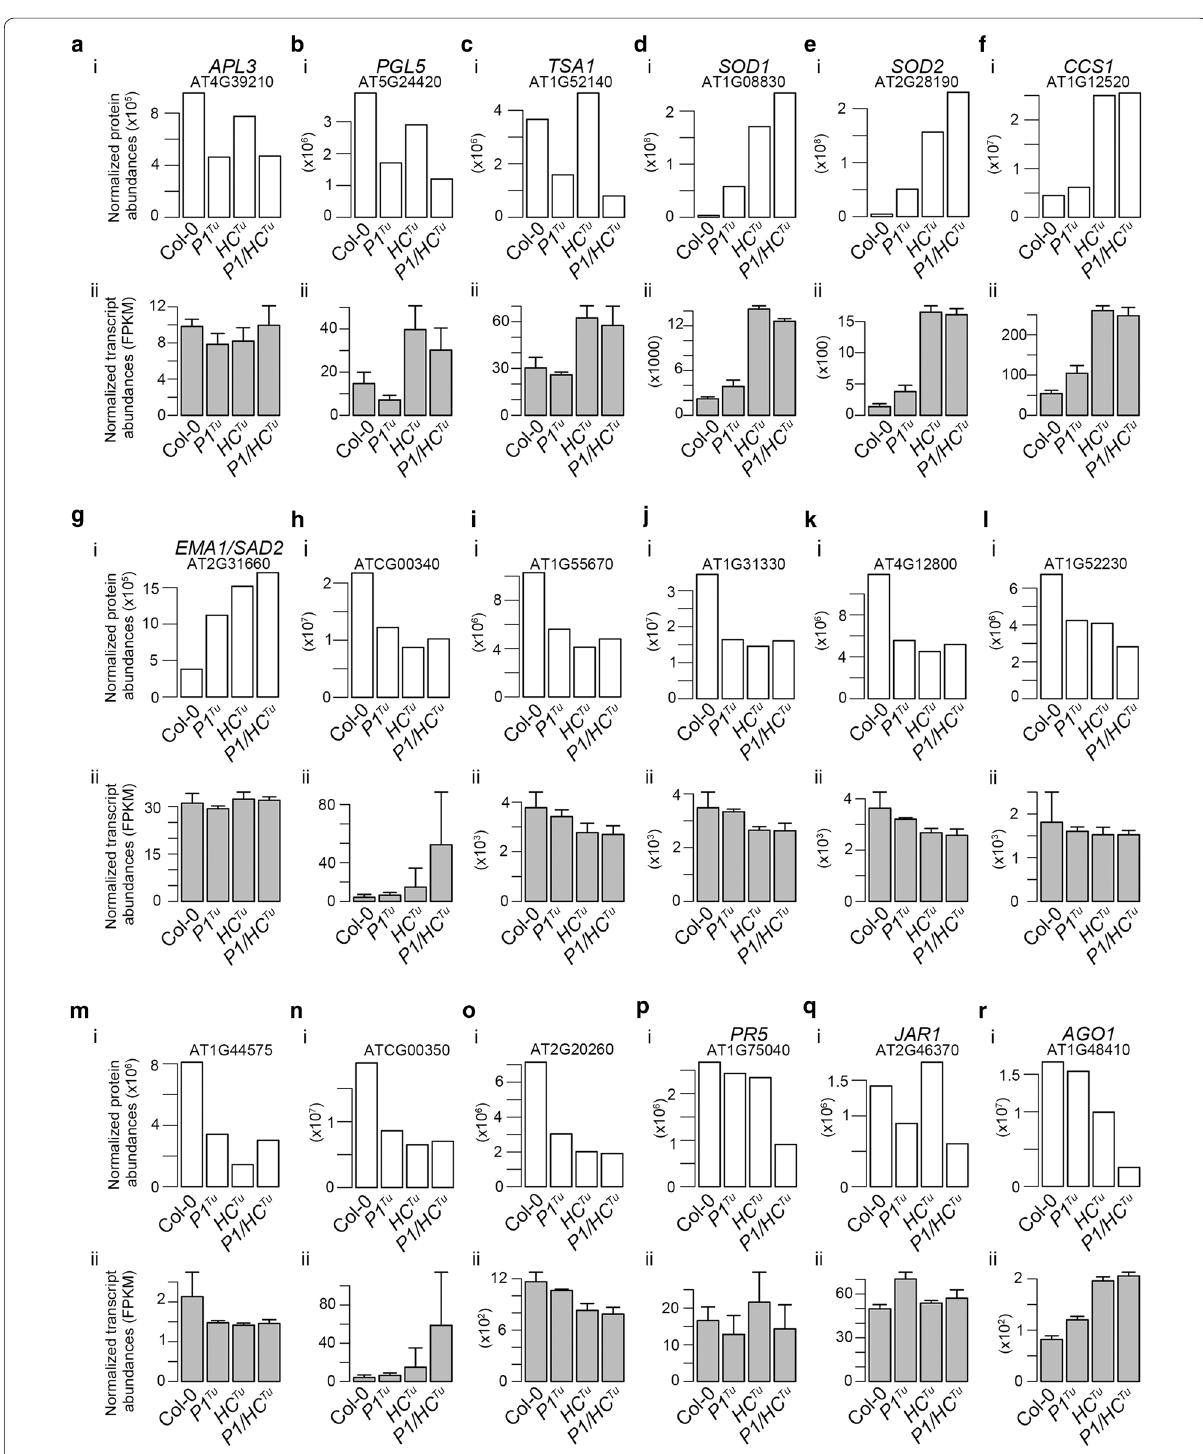
Fig. 4 The protein and transcript levels of critical genes in various transgenic plants. (a–r) Genes that had a significant difference in protein levels (panel ii) between Col‑0 and P1/HC Tu plants were identified and their transcript levels were observed (panel i) in Col‑0, P1 Tu , HC Tu , and P1/HC Tu plants. The fragments per kilobase of transcript per million (FPKM) were used to represent the normalized transcript expression. The bars represent standard deviations ( n 3). Normalized abundances were used to represent the protein =